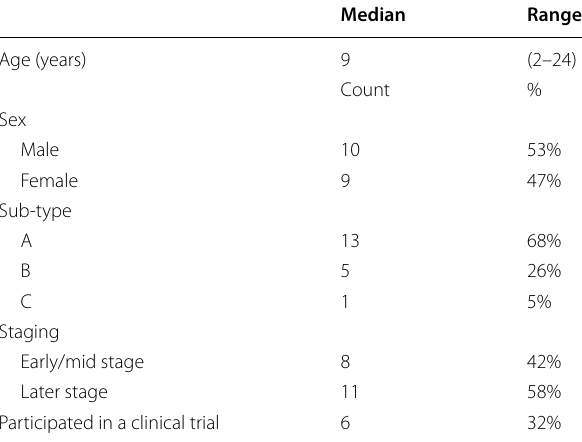
Table 5 Characteristics of oldest child with Sanfilippo syndrome: